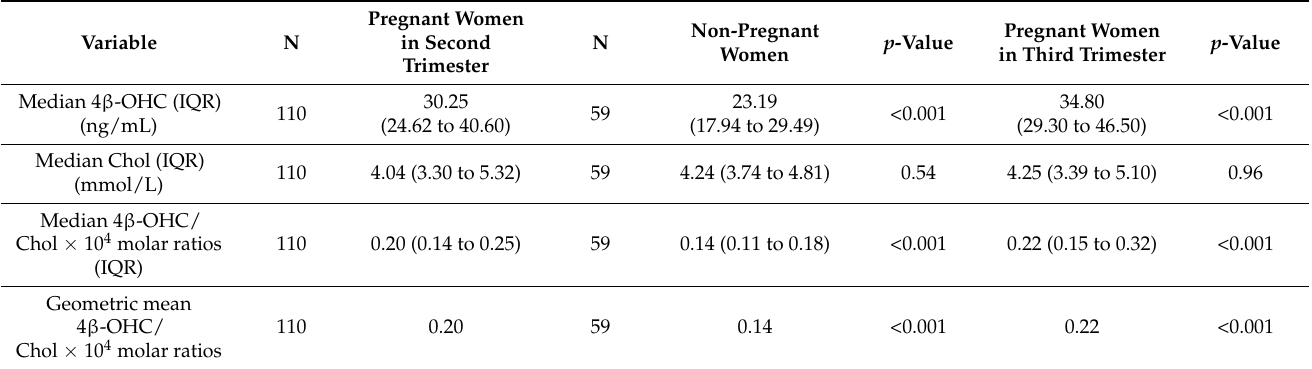
Table 3. Comparison of median plasma 4 β -OHC, Chol and 4 β -OHC/Chol ratio between